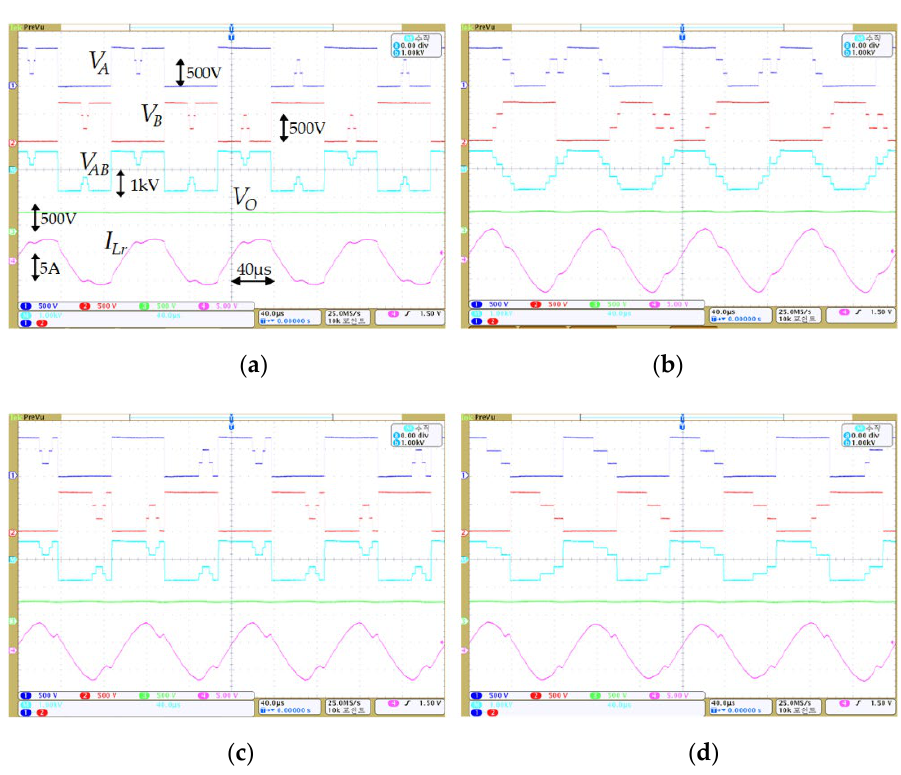
Figure 19. Experimental results for the ( a ) middle, ( b ) edge, ( c ) rear, and ( d ) end sags when P O = 1500 W.